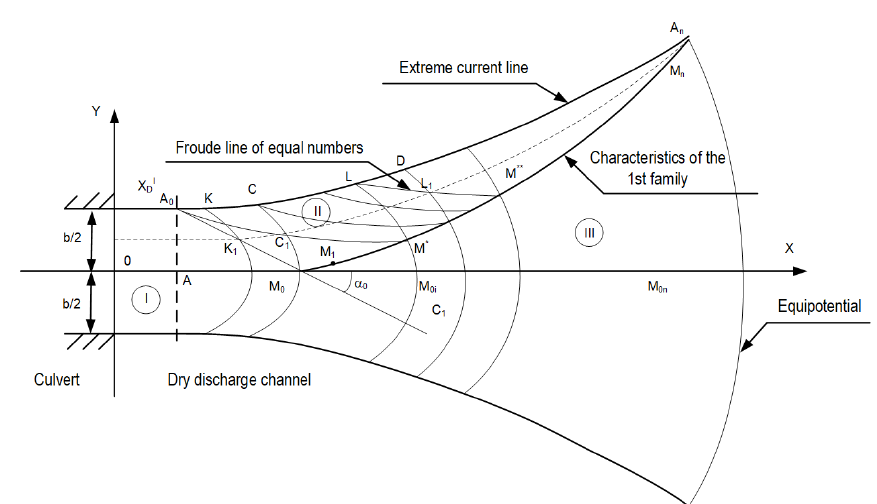
Figure 5. Flow spread diagram to the new mathematical